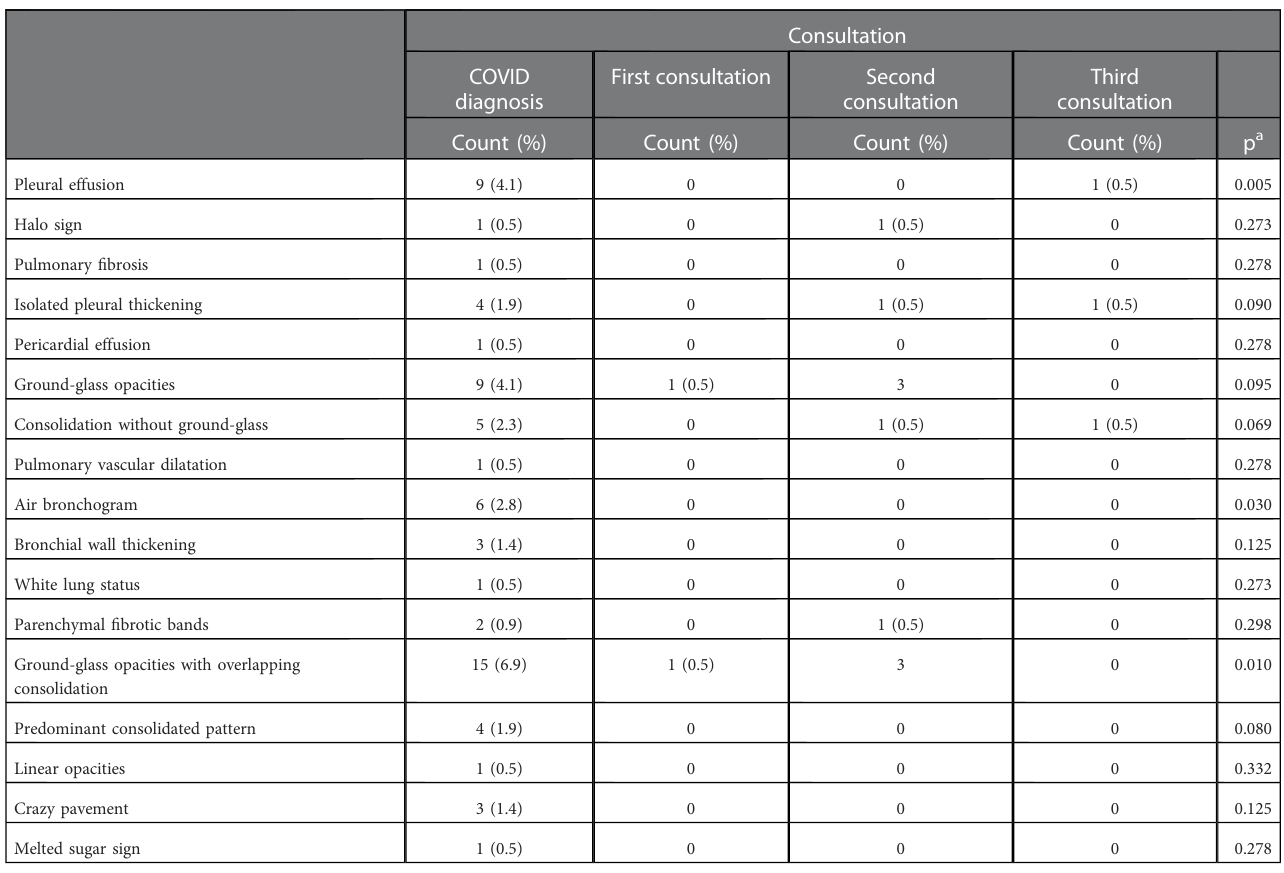
TABLE 4 Tomographic alteration at diagnosis and follow-up